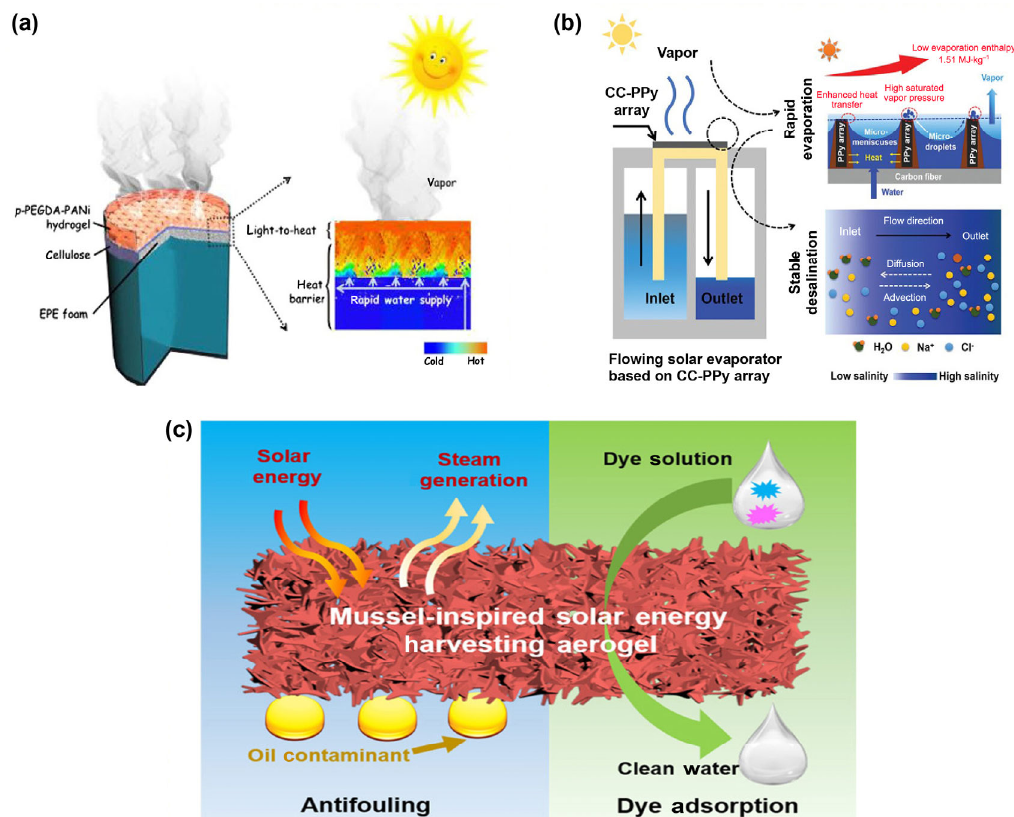
Figure 4 (a) The evaporation mechanism of the p-PEGDA-PANI based evaporator. Reproduced with permission from Ref. [61], © American Chemical Society 2018. (b) The structure of the solar evaporator is based on the CC-PPy array. Reproduced with permission from Ref. [62], © Wiley-VCH GmbH 2022. (c) The PDA-CA device for solar steam generation, antifouling, and dye adsorption. Reproduced with permission from Ref. [63], © American Chemical Society